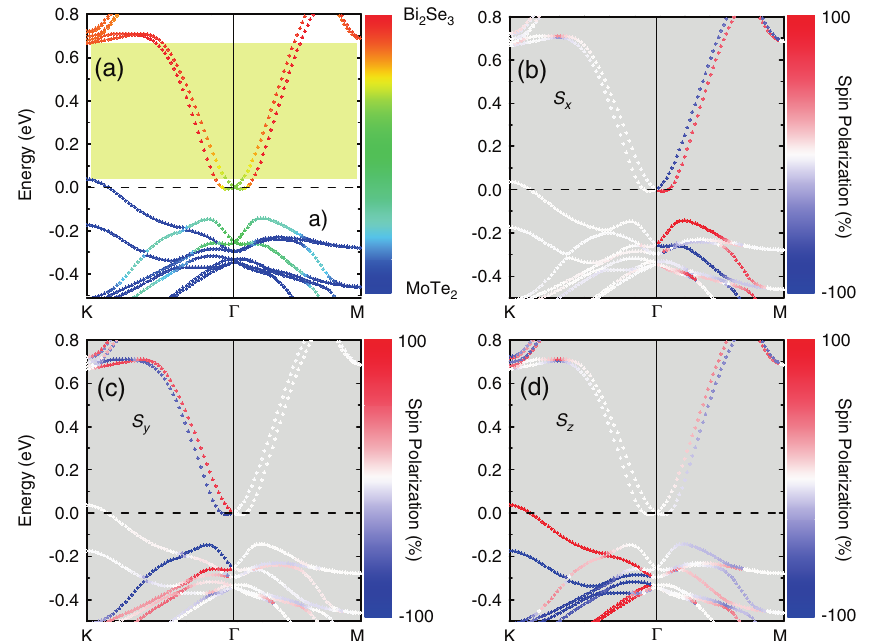
Fig. 2 Electronic structures of the 1QL-Bi 2 Se 3 /1TL-MoTe 2 junction, where a the Bi 2 Se 3 and the MoTe 2 components, b – d spin polarization along the x , y and z directions are represented by the color of the dots . The yellow-shaded region in a indicates the energy window (over 0.6 eV) for ideal Rashba bands without any other electronic